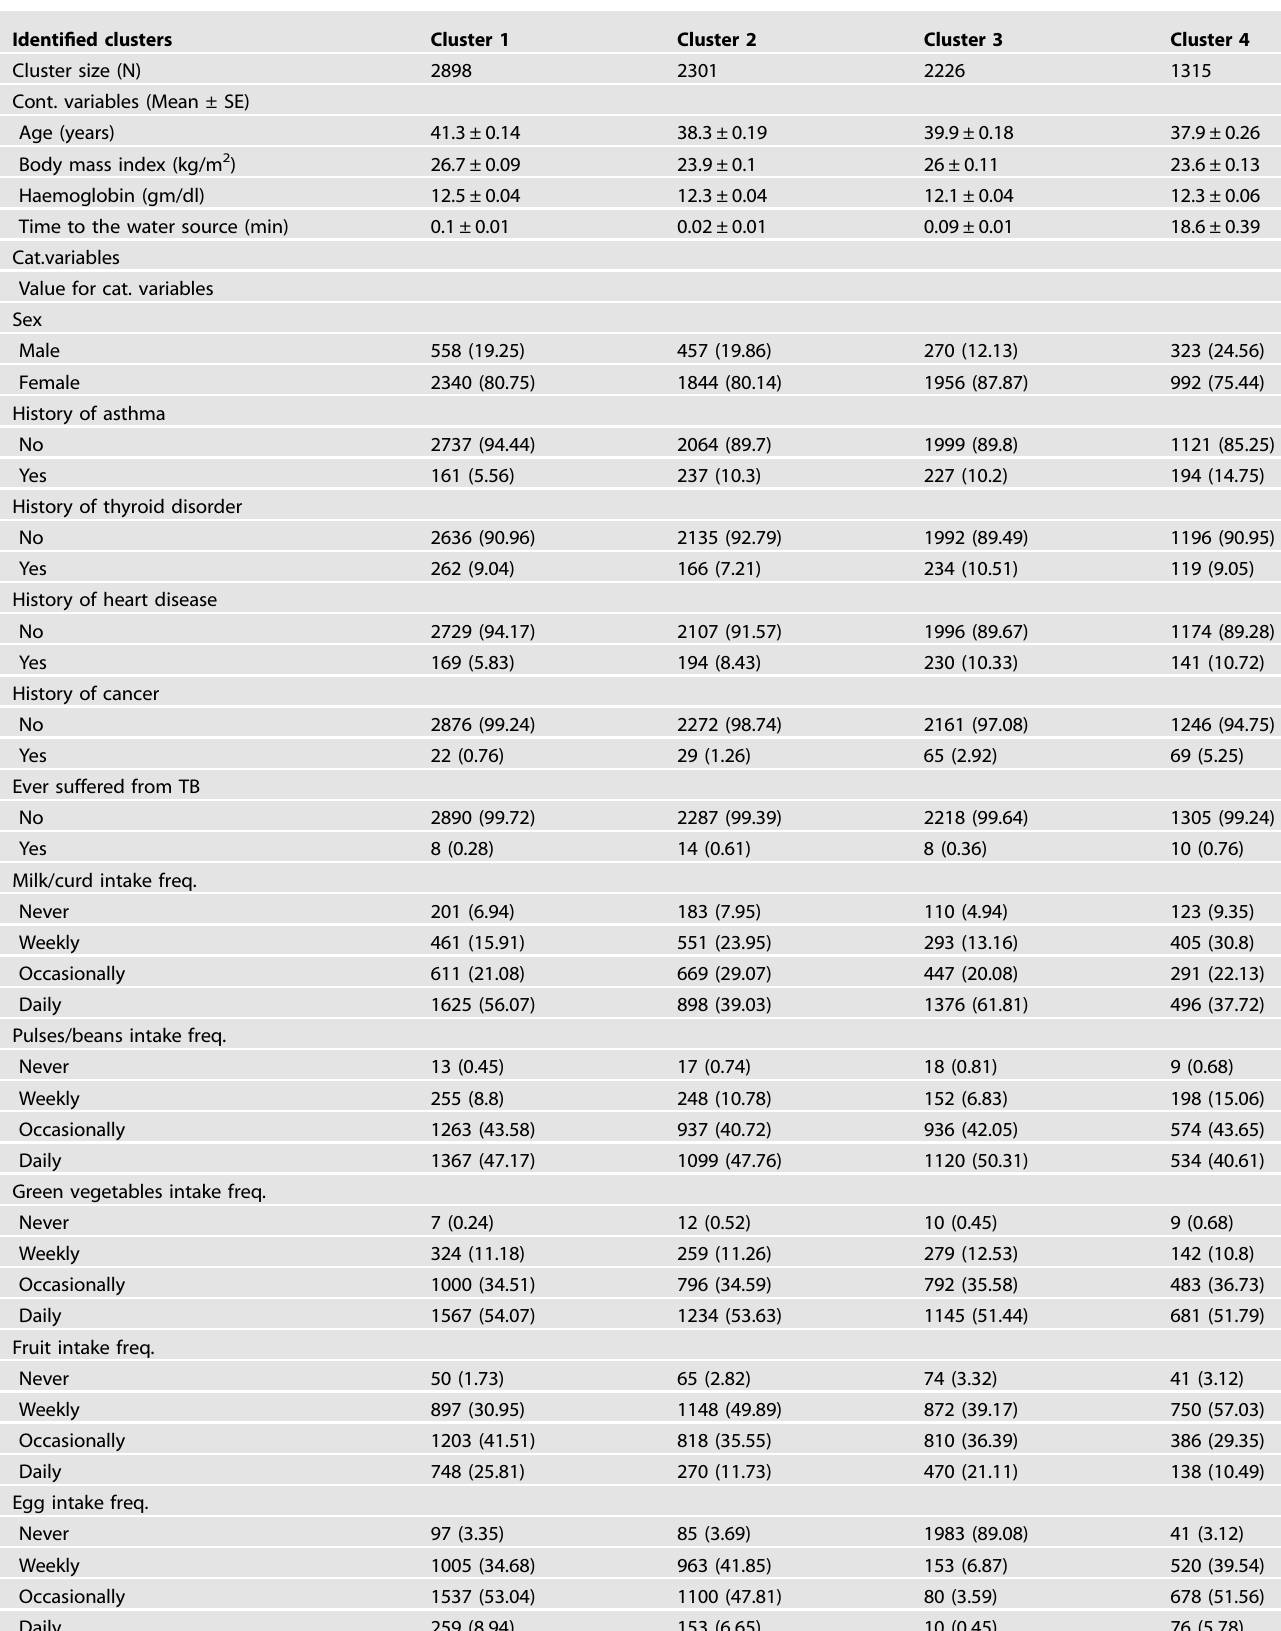
Table 1. Detailed cluster-speci fi c analysis for all numerical and categorical